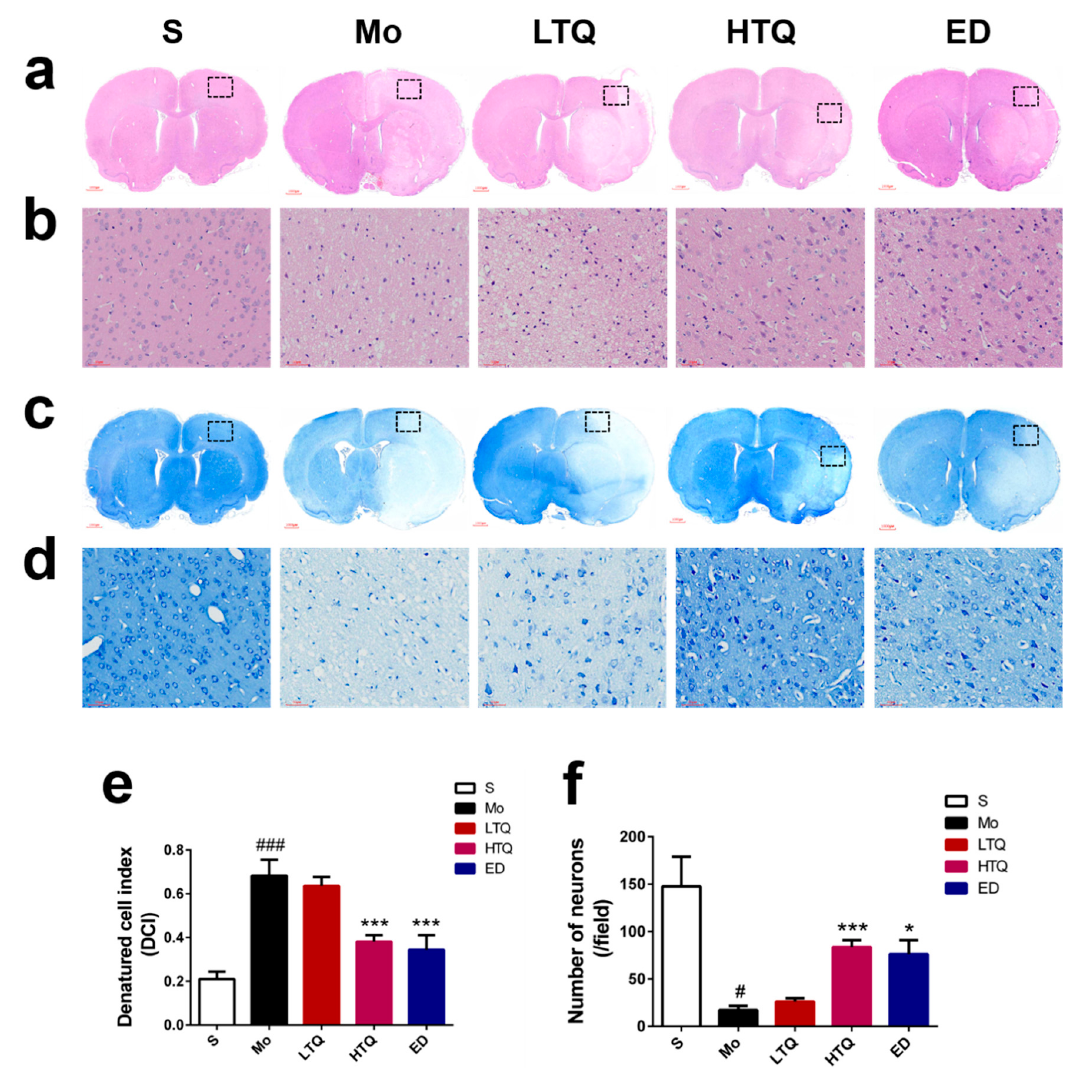
Figure 2. Effect of thymoquinone treatment on the morphology of cortical neuronal cells following cerebral ischemia reperfusion injury. ( a , b ) Representative photomicrographs of hematoxylin and eosin (HE) staining (5× and 200×). ( c , d ) Representative photomicrographs of Nissl staining (5× and 200×). ( e ) Quantification of denatured cells. ( f ) Quantification of Nissl-positive neurons. Black rectangular areas in the ischemic ipsilateral cortex of penumbra were amplified by automated microscopy and represent the regions selected for histology analysis. Data are expressed as mean ± SD ( n = 4), # p < 0.05, ### p < 0.001 vs. sham group; * p < 0.05, *** p < 0.001 vs. model group. S: Sham; Mo: Model; LTQ: 2.5 mg/kg thymoquinone; HTQ: 5 mg/kg thymoquinone; ED: 3 mg/kg edaravone.